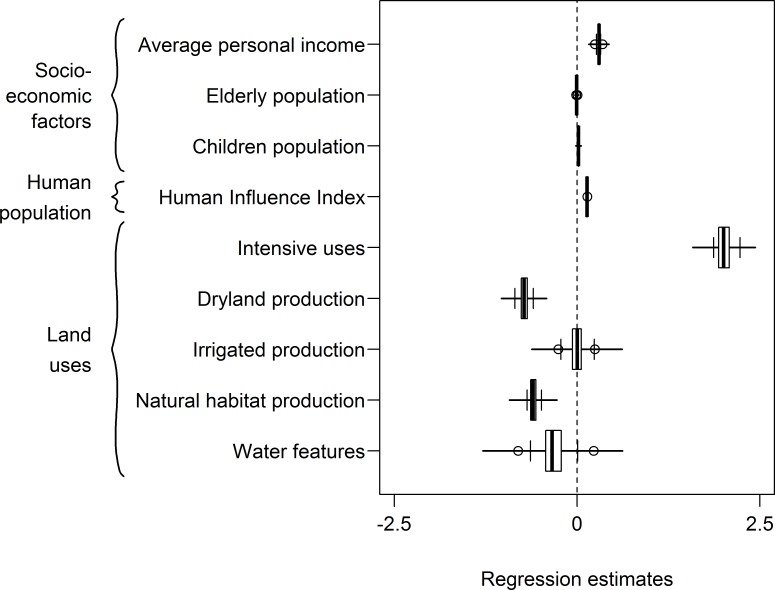
Coefficient plot of the generalised linear model for the predictors of the spatial distribution of bird escapes in Australia.Positive regression estimates represent higher frequency of escapes, and vice versa.